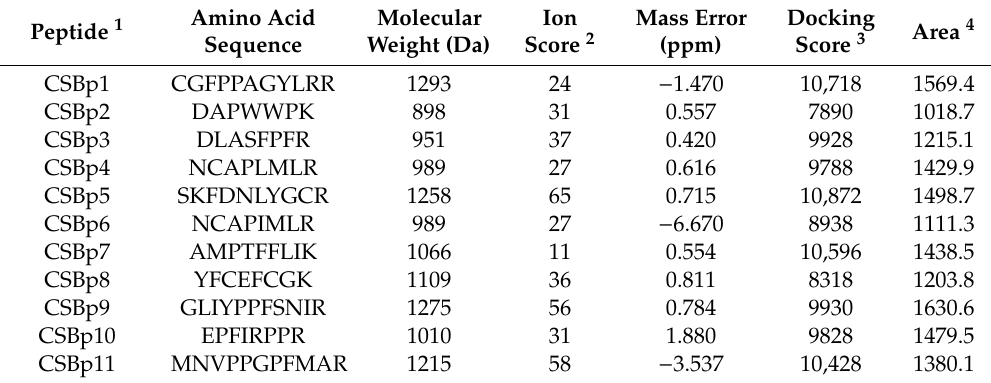
Table 2. LC-MS / MS and docking parameters of corn silk